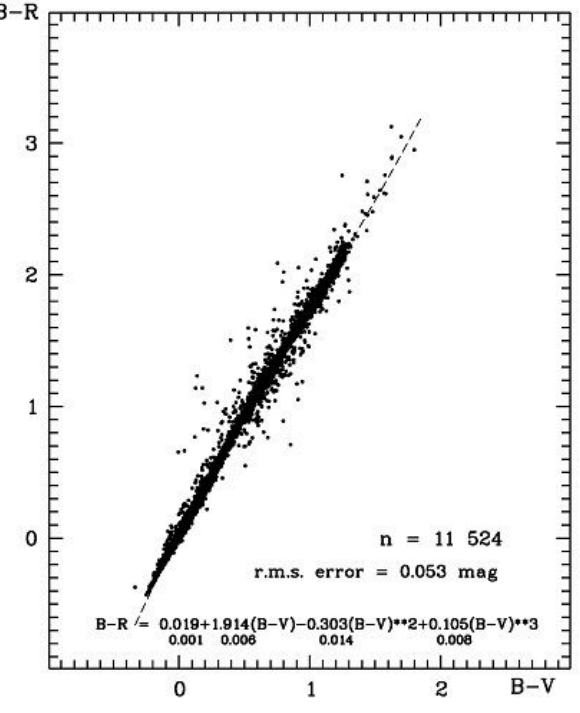
Figure 10. Comparing the B-R photoelectric quantities with the color indices (B-V) of the Tycho-2